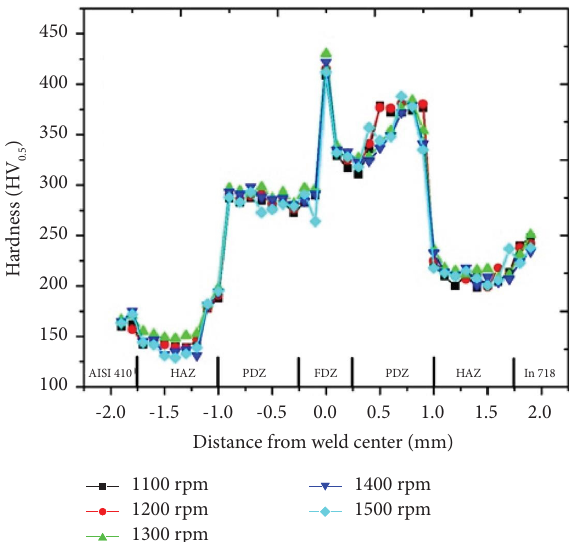
Figure 10: Hardness variation in diferent rotational